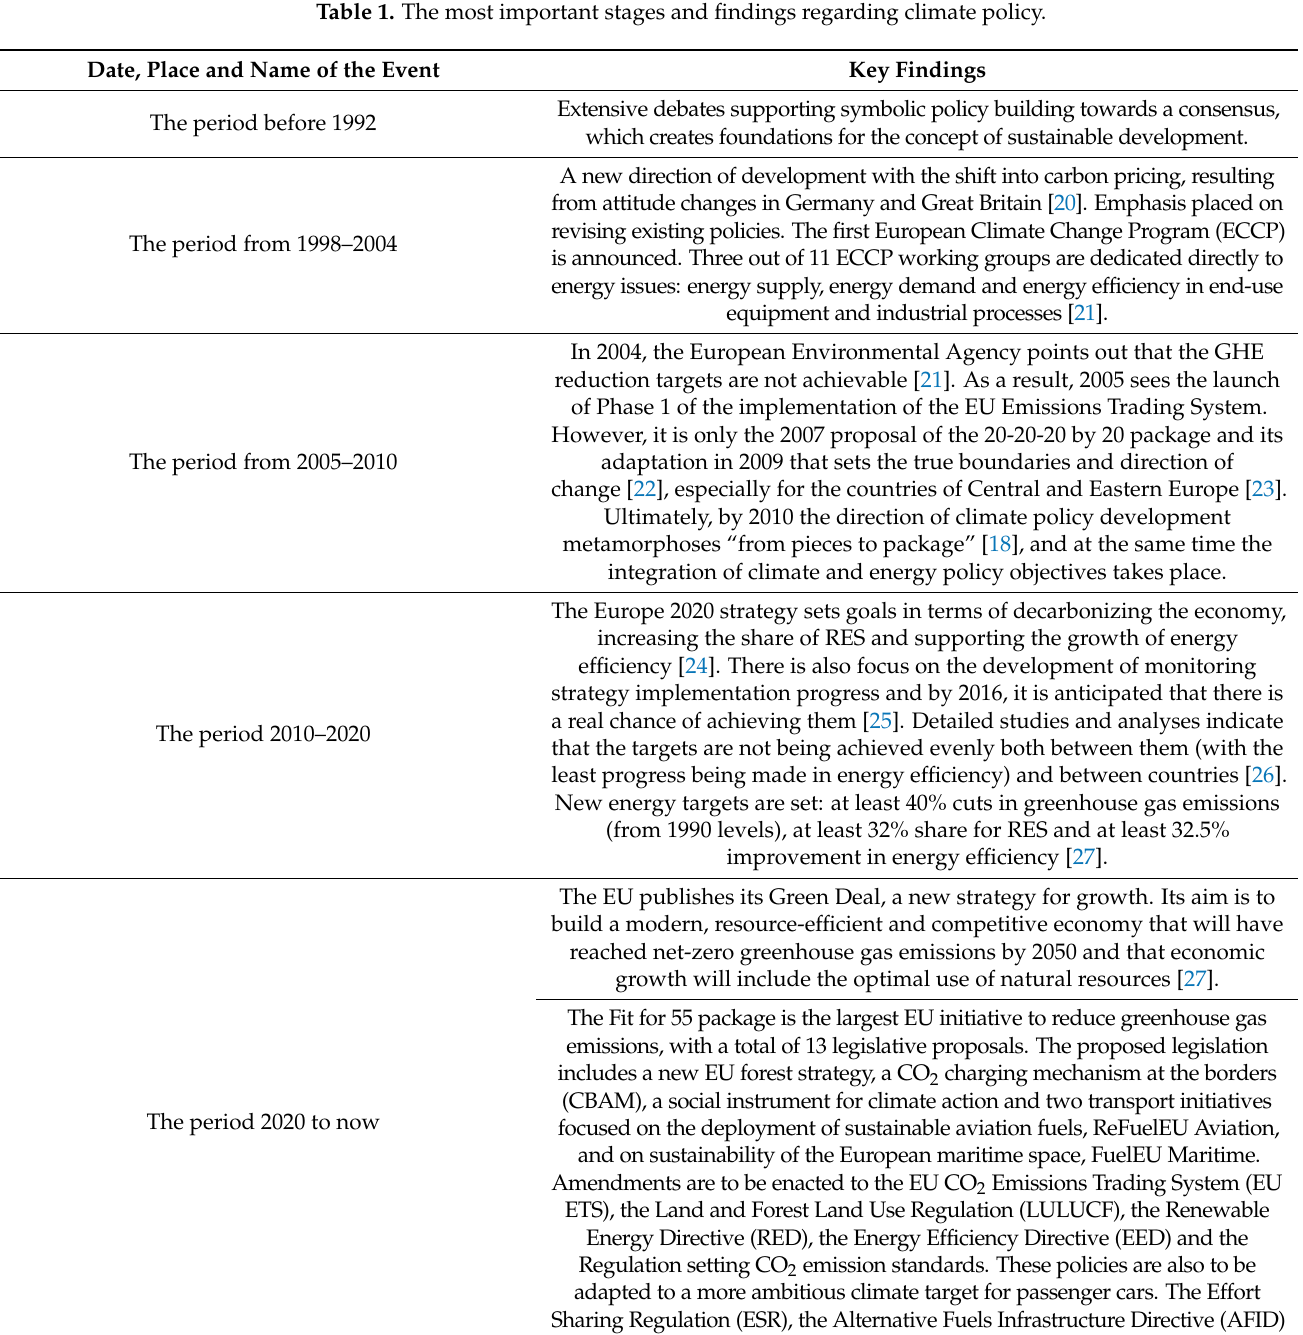
Table 1. The most important stages and findings regarding climate